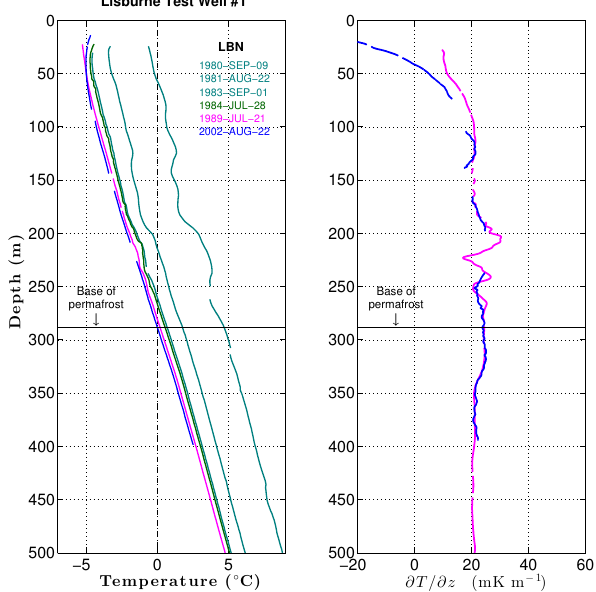
Earth Syst. Sci. Data www.earth-syst-sci-data.net www.earth-syst-sci-data.net